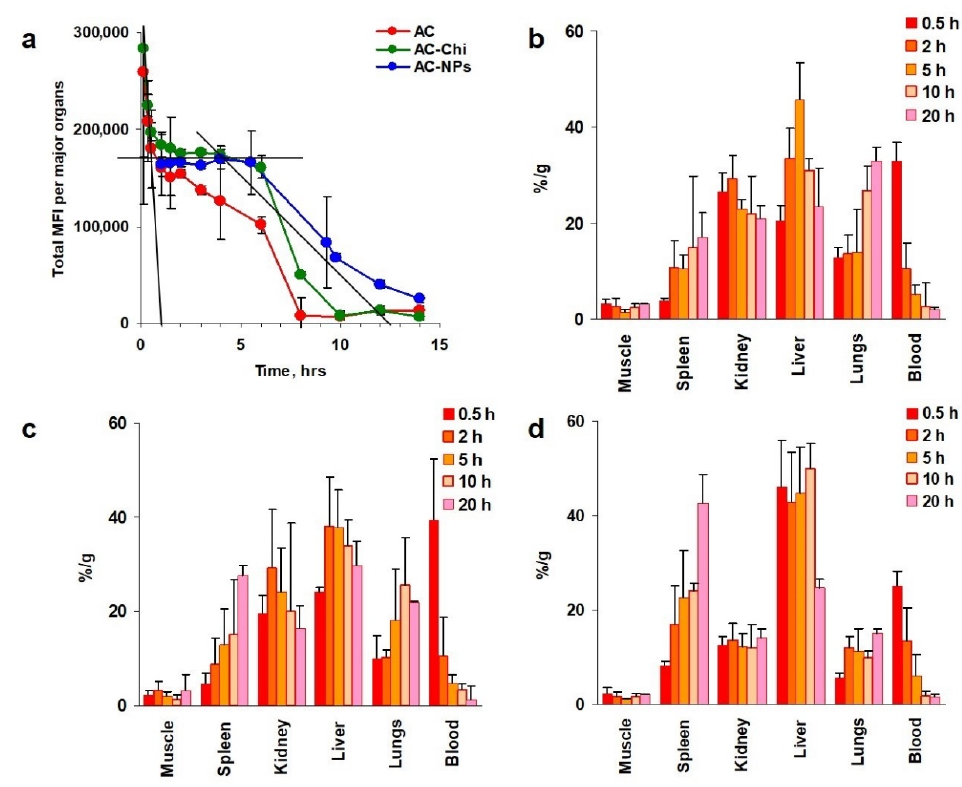
Figure 4. Biodistribution of furano-allocolchicinoid formulations in mice. ( a ) Total MFI collected from organs and blood serum. ( b – d ) AC , AC-Chi , and AC-NPs were IV injected and extracted at 0.5–20 h post injection. Biodistribution of AC ( b ), AC-Chi ( c ), and AC-NPs ( d ) in dynamics. Data are shown as percentages per gram of tissue